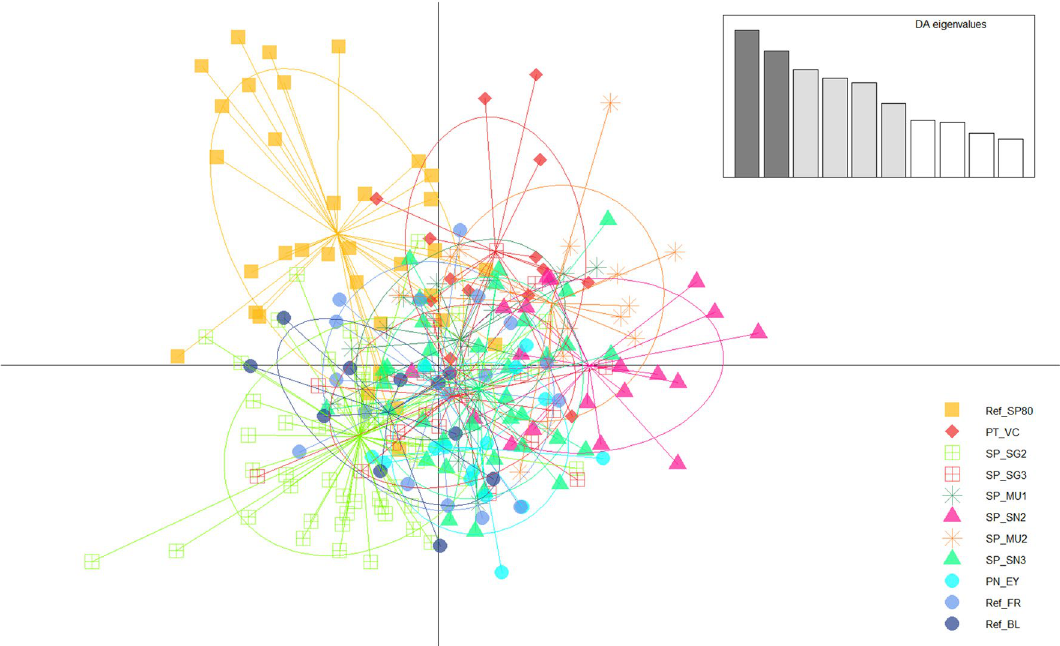
Figure 4. Scatter plot from discriminant analysis of principal components. 80 principal components (PC) were selected after α-score estimations to avoid overfitting. Chosen discriminant analysis eigenvalues are depicted in the top right of the plot. Ellipses indicate the 95% confidence interval of assignment, yellow squares identify bumblebee individuals collected before the 1990s, orange rhombuses represent Portuguese samples, green represents individuals from Sierra de Guadarrama, pink represents individuals from the Sierra Nevada and blue represents samples from outside the Iberian Peninsula, as detailed in the figure legend at the bottom